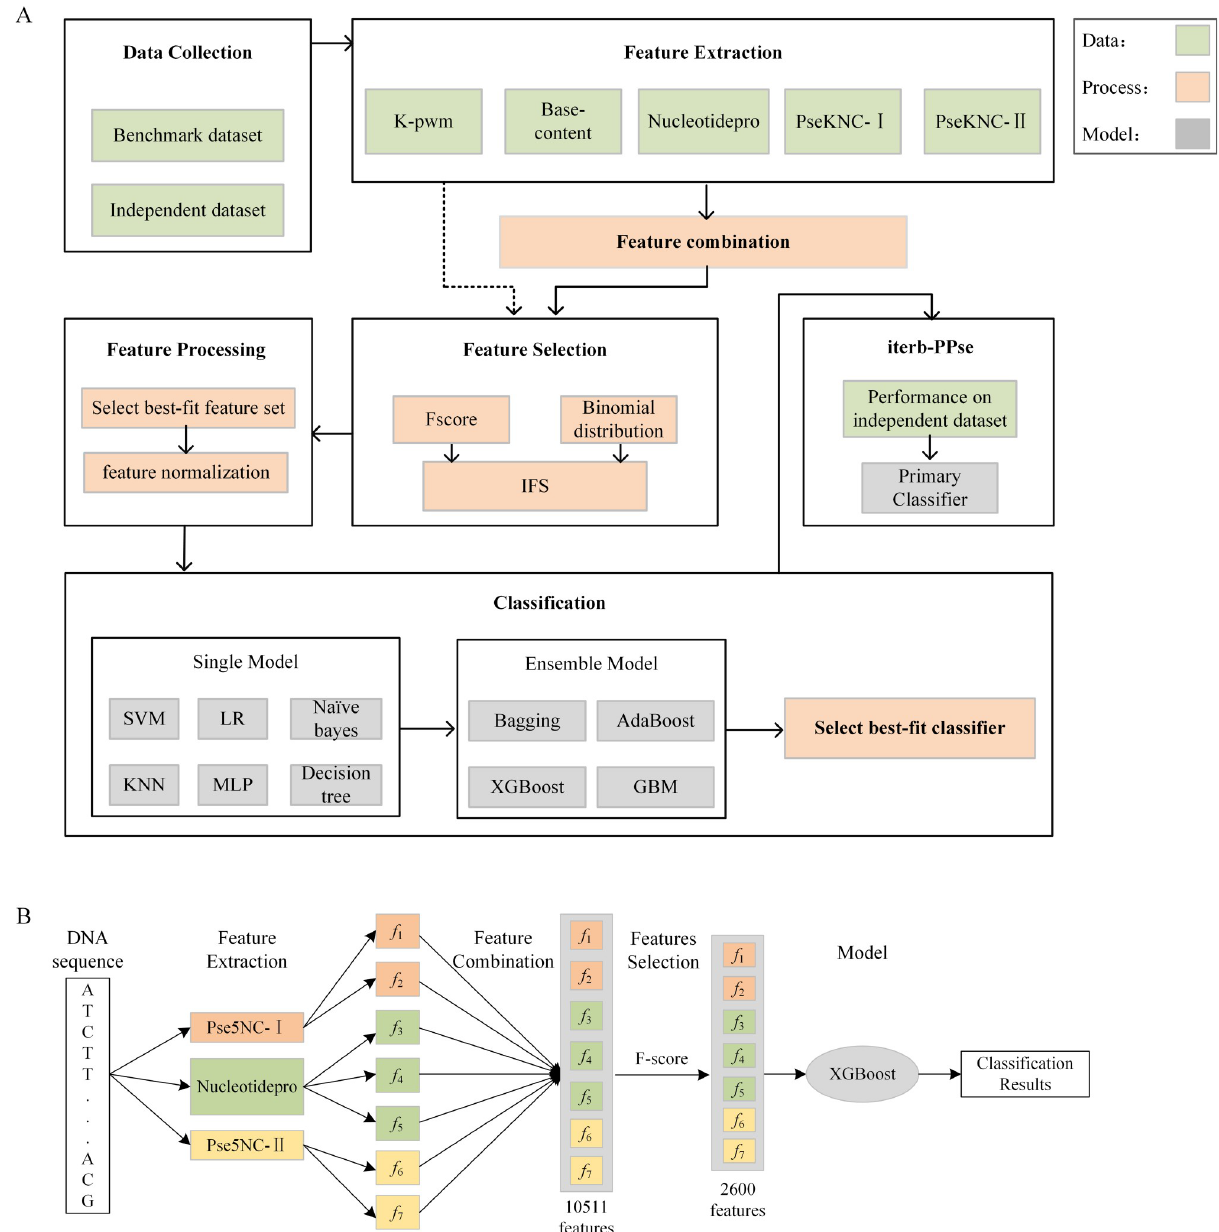
Fig 2. The overall framework. A shows main steps of our study. First step is using five extraction methods to deal datasets, then select more important features by two-step feature selection method, finally compared different models using the selected features. The “iterb-PPse” is the method we proposed to predict terminators. B illustrates the prediction process of “iterm-PPse”. It extracts three features from gene sequences at first, namely Pse5NC-I, Pse5NC-II, 47 nucleotide properties. Then sort all features using F-score and select the best feature set by IFS. Finally utilizes trained XGBoost to determine whether these sequences are